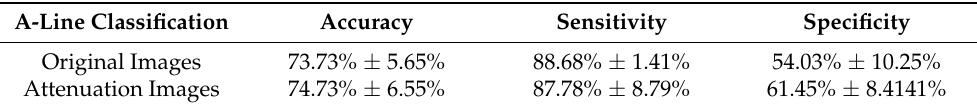
Table 2. The mean test accuracy (sensitivity/specificity) ± their standard deviation of A-lines (1 × 90) classification for original images and attenuation images.